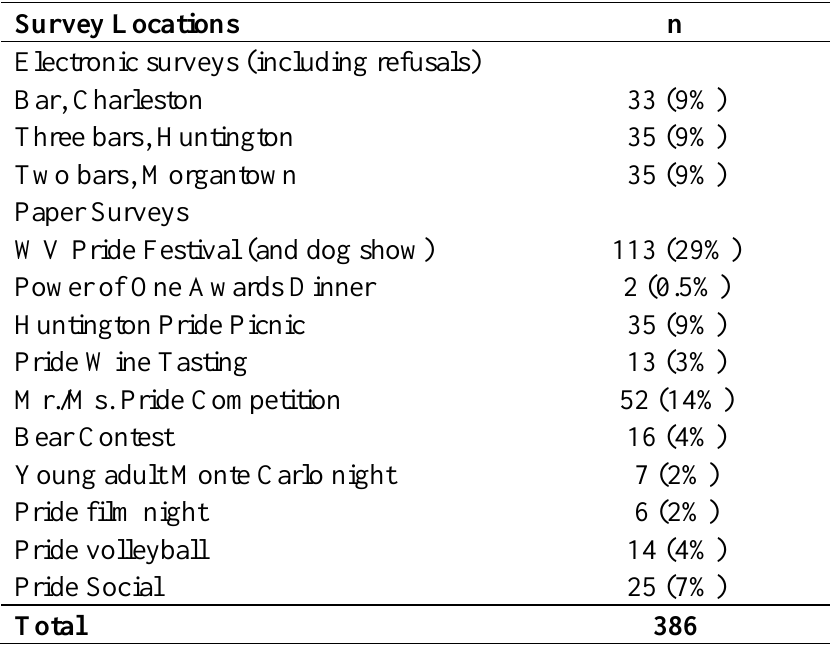
Table 1. Survey participation.